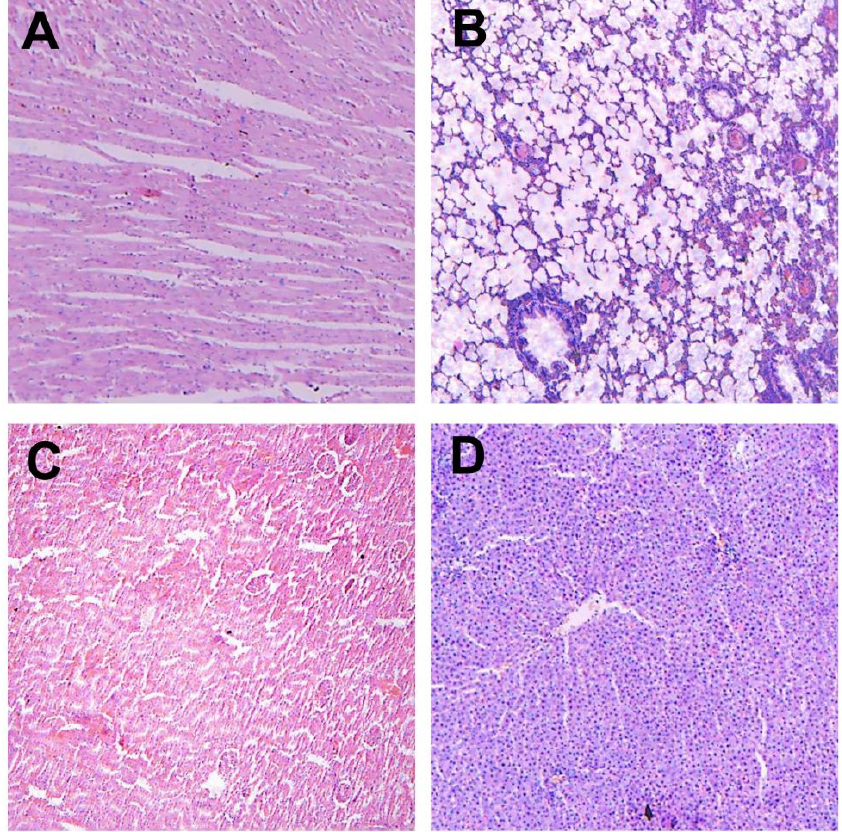
Figure 1. Histological examination after 28-day sub-chronic toxicity test. ( A ) myocardium (100×); ( B ) lung (100×); ( C ) kidney (100×); ( D ) liver (100×).